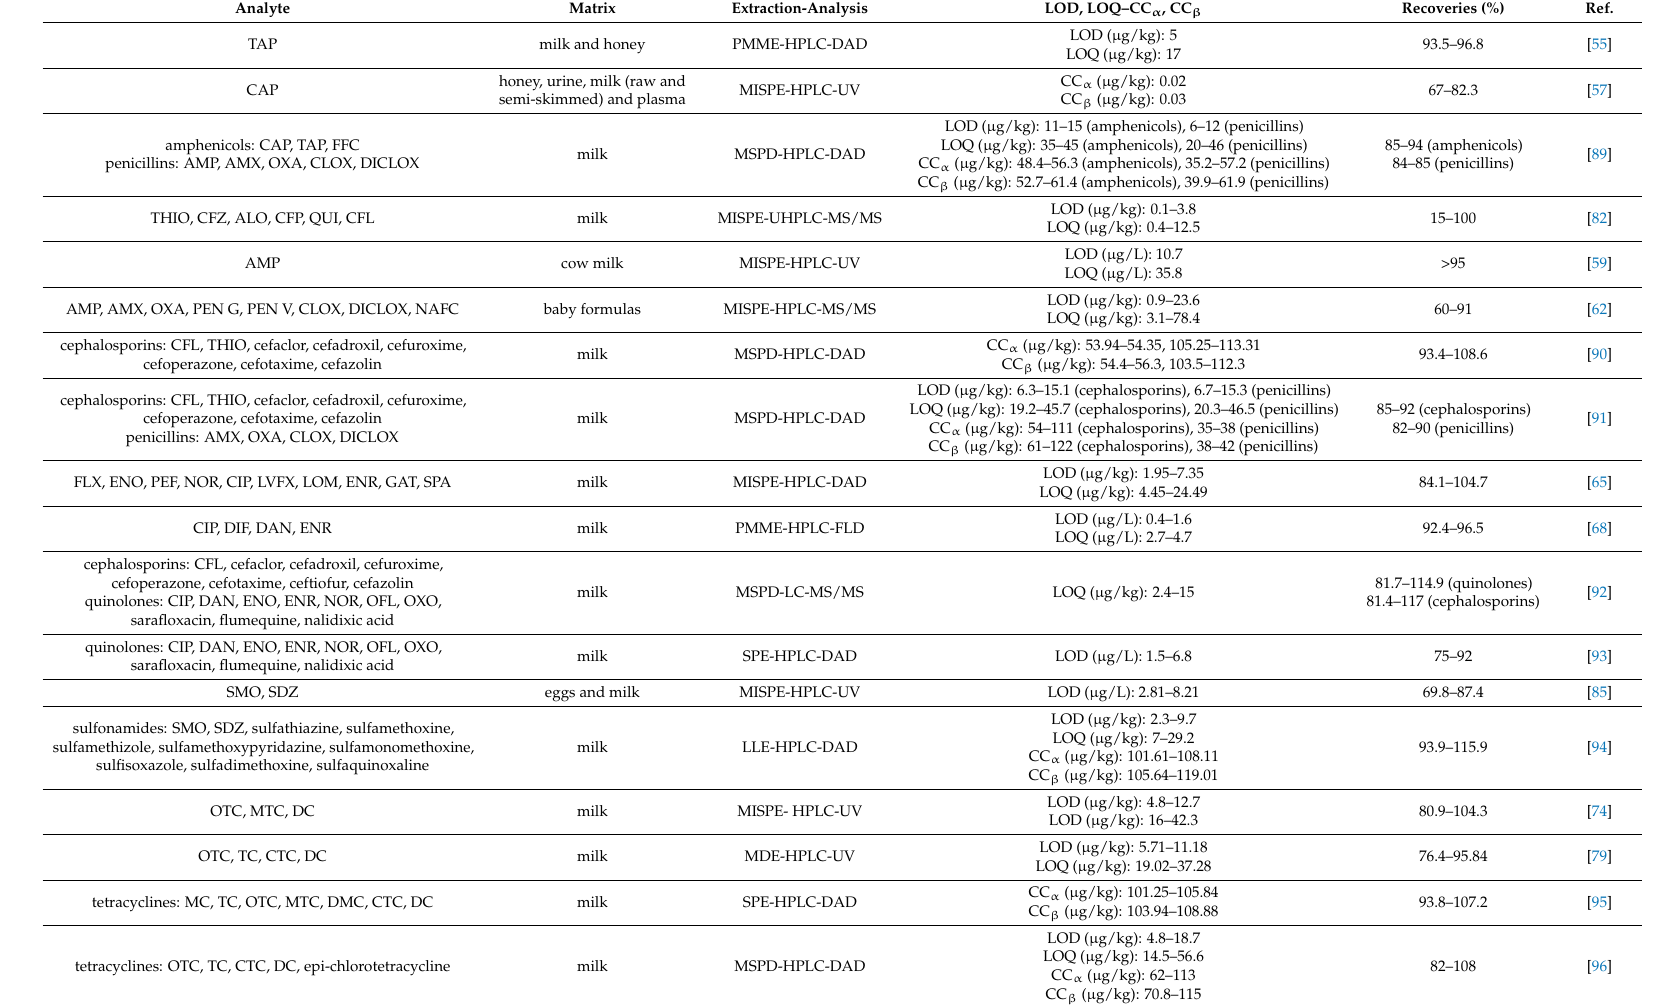
Table 6. MIPs applications and conventional extraction